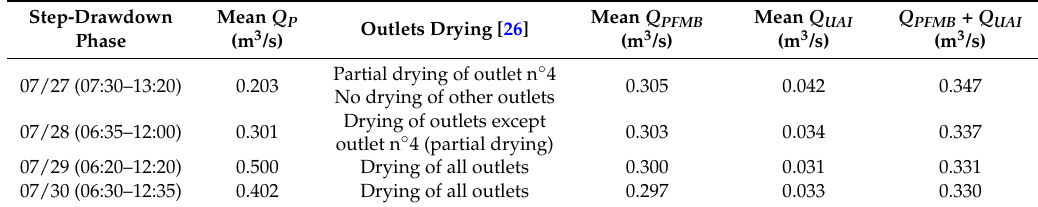
Table 2. Step drawdown pumping, Q PFMB from Equation (13), Q UAI recorded at Buèges, total